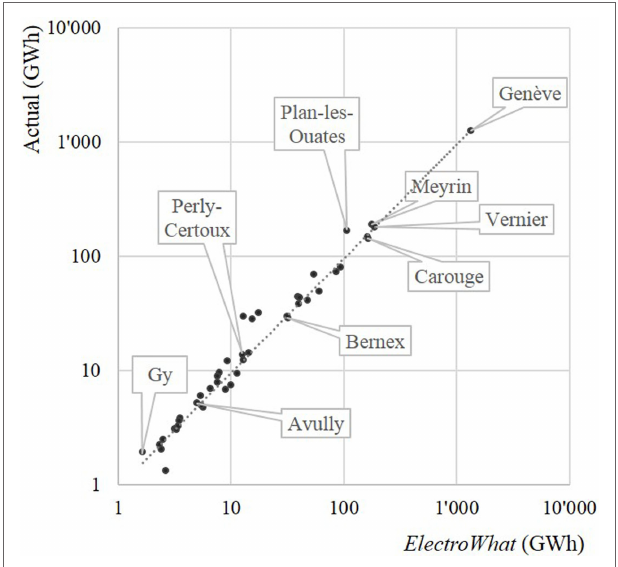
FIGURE 9 | Actual versus estimated electricity consumption for the year 2008 of the 44 municipalities of the Canton of Geneva.